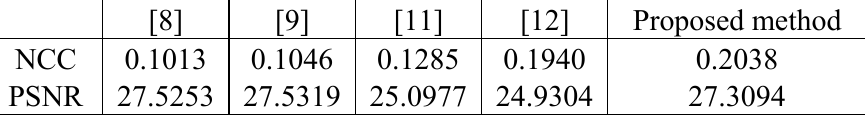
Table 2. The NCC and PSNR of references and our proposed